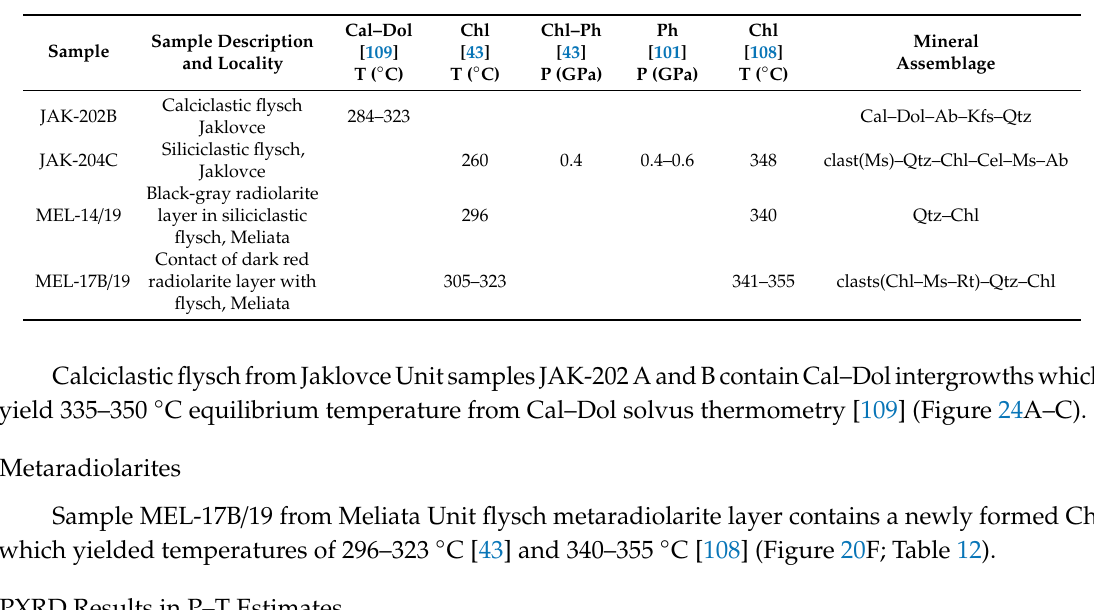
Figure 30. Meliata Unit P–T diagrams showing univariant curves and the point intersecting Chl–Ph(Cel-Ms) pairs at equilibrium P–T conditions of 260 ° C at 0.4 GPa (s. JAK-204C). Diagrams were created by MATLAB script [43]. Crosses represent Chl–Ph pairs equilibrium tolerance. Table 12. Meliata Unit rock P–T estimates from combined